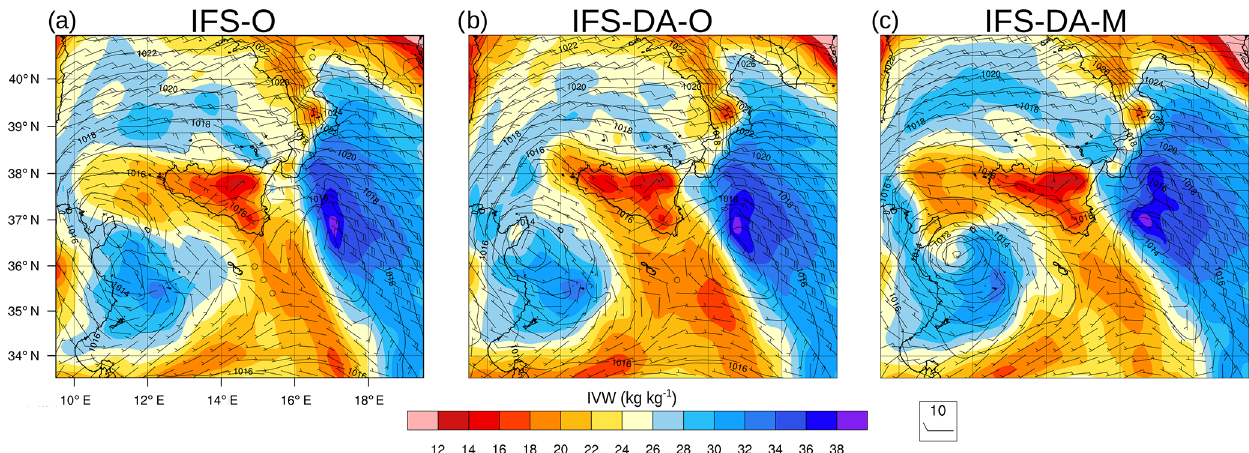
Figure 14. Same as Fig. 8, but at 21:00UTC on 31 October